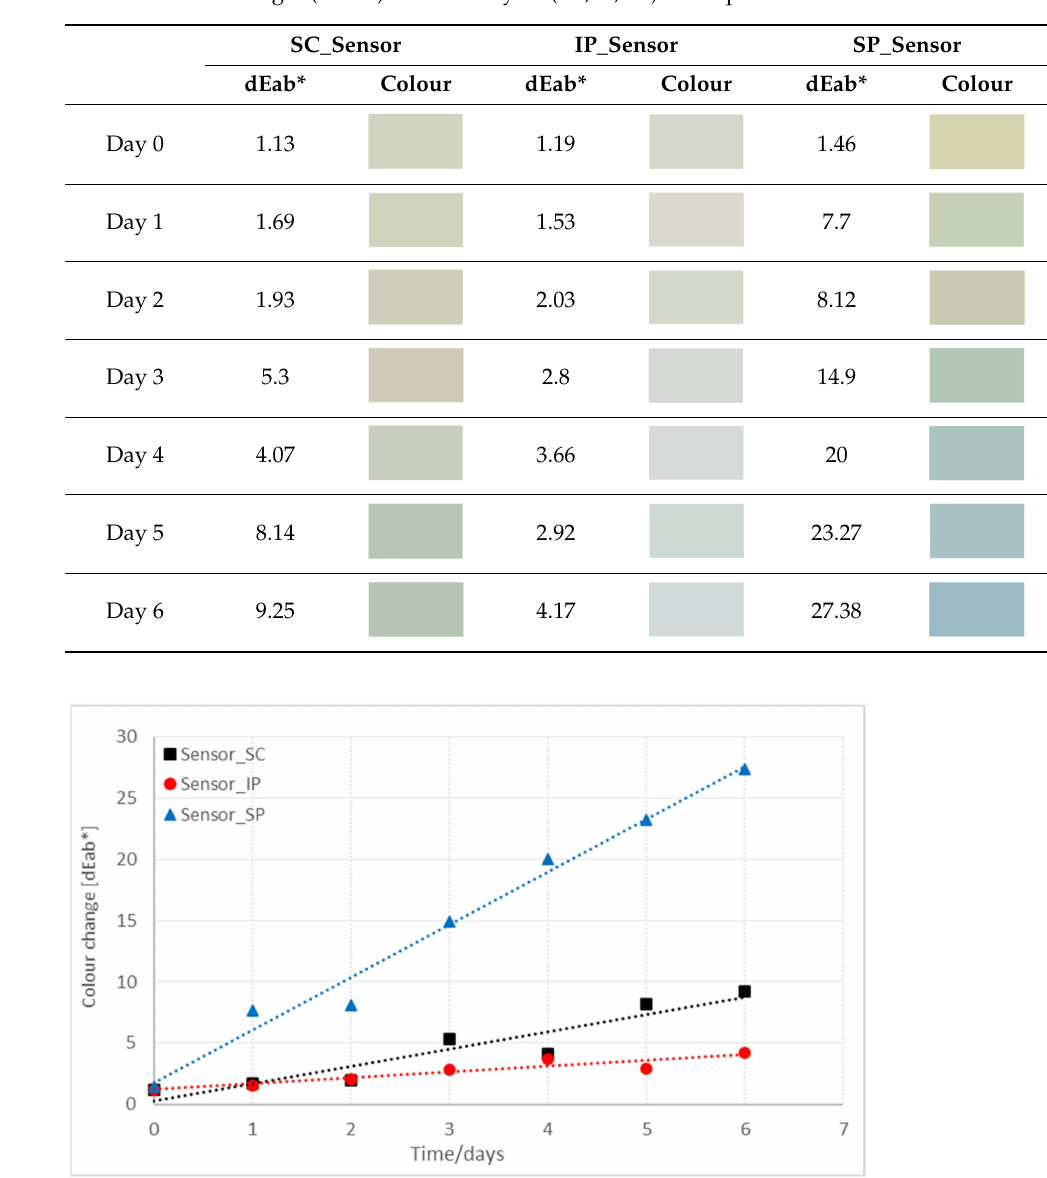
Table 5. Colour changes (dEab*) of sensor layers (SC, IP, SP) in the presence of fish meat over time.